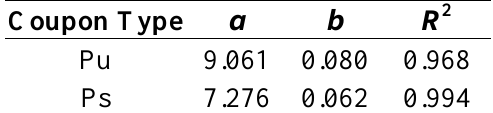
%, versus the curing pressure, P V